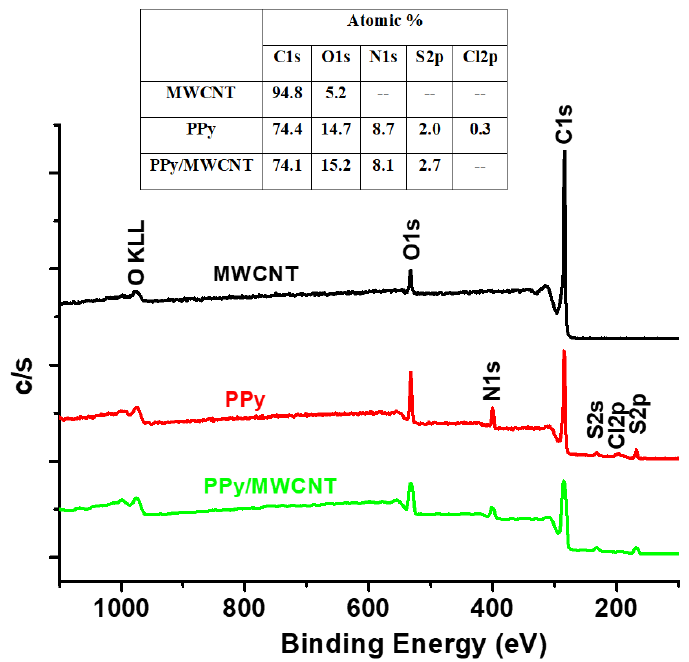
Figure 7. Typical XPS survey profiles of MWCNTs, PPy, and MWCNTs/ PPy nanocomposites (PN2). The XPS elemental analysis and their atomic percentage are also shown in the table.